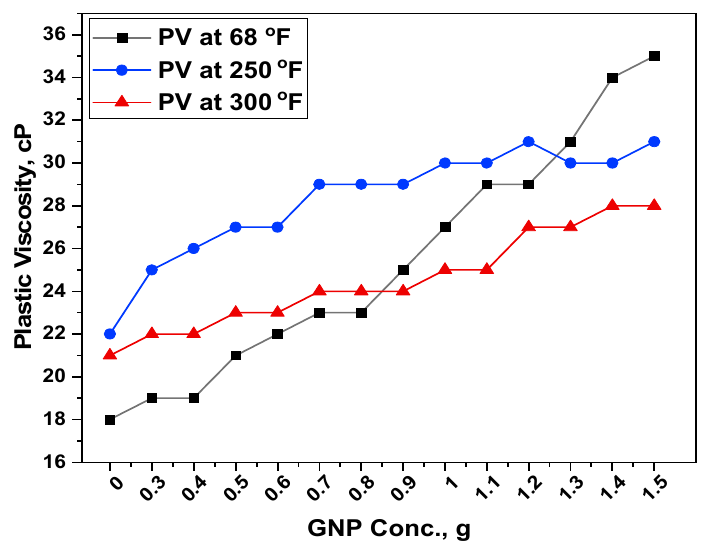
Figure 4. Response of GNP-Starch on the plastic viscosity (PV) of the formulated muds.